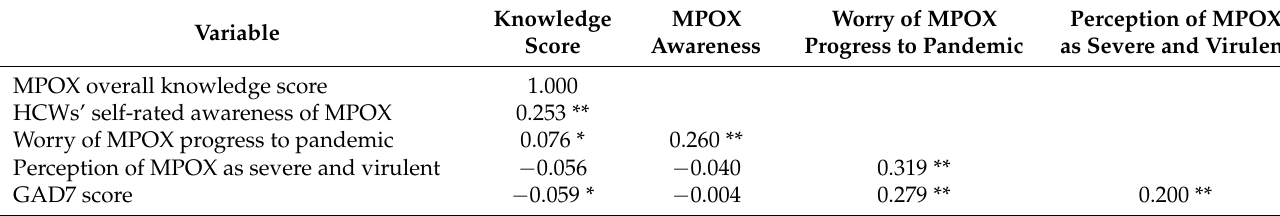
Table 5. Bivariate correlations between HCWs’ MPOX knowledge, awareness, perception of severity, and worry about its progress to pandemic status. (KSA, 27 May to 5 June